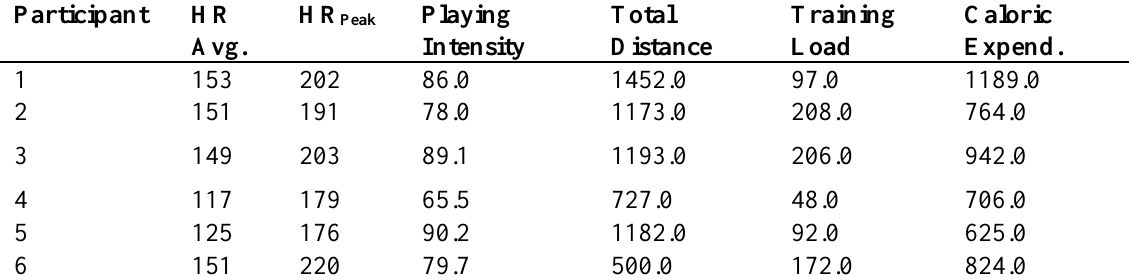
Table 2. Wheelchair basketball performance characteristics in Game 1